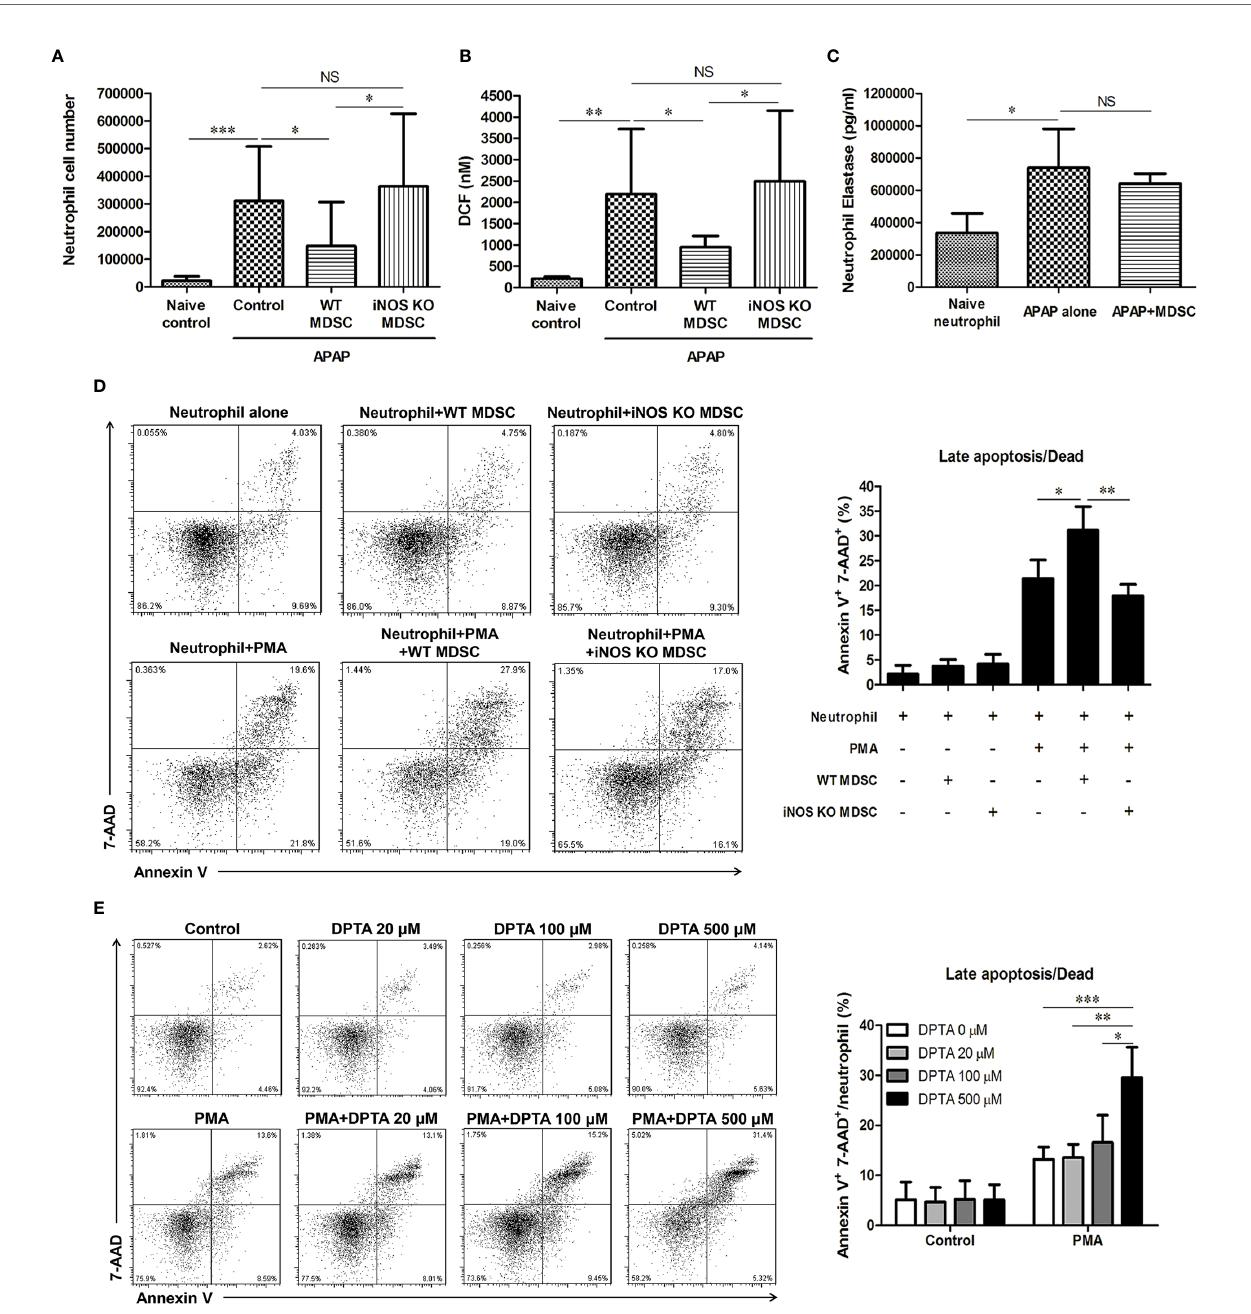
FIGURE 7 | Nitric oxide promotes the apoptosis of activated neutrophil (A) The hepatic cell numbers of CD11b + Ly6G + neutrophil at 6 h after acetaminophen (APAP) injection (n=6 – 8). *P < 0.05, ***P < 0.001, NS, no signi fi cance, Kruskal-Wallis test. (B) Total ROS/RNS levels in liver tissue are represented by DCF concentration. *P < 0.05, **P < 0.01, NS, no signi fi cance, Kruskal-Wallis test. (C) Hepatic neutrophils from the mice injected with APAP alone or combined with adoptive transfer of TNF- a /lipopolysaccharide (LPS) MDSC were isolated to measure the levels of elastase (n=6 per group). Naïve neutrophils were the blood neutrophils of healthy mice (n=3). *P < 0.05, NS, no signi fi cance, Kruskal-Wallis test. For neutrophil apoptosis assessment, 1×10 5 neutrophils were cultured with MDSCs in equal numbers (D) or DPTA (E) for 3 h (n=9 per group). 50nM of PMA was added for neutrophil activation. The apoptosis of neutrophil was analyzed by fl ow cytometry. *P < 0.05, **P < 0.01, ***P < 0.001,. Kruskal-Wallis test. Data were expressed as mean ±